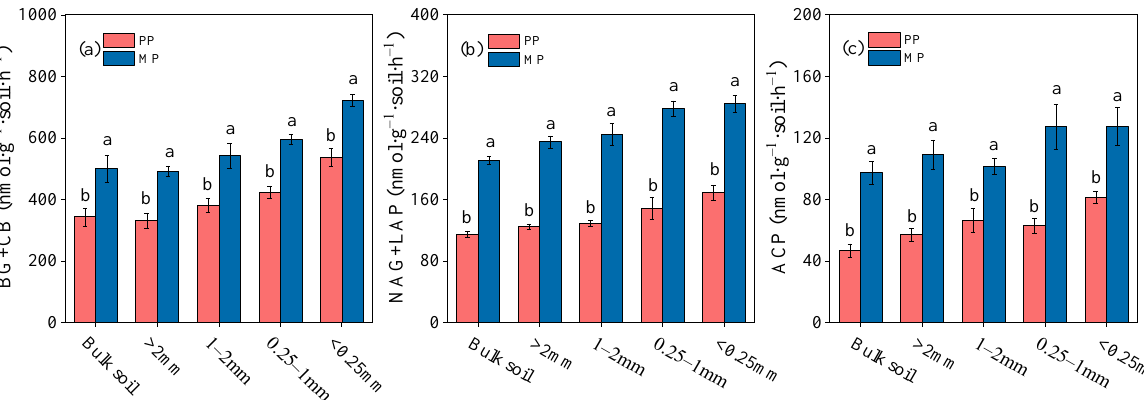
Figure 1. Soil extracellular enzymatic activity (EEA) within bulk soil and aggregates in PP and MP ( a – c ). Different lowercase letters denote marked variations between the PP and the MP ( p < 0.05). Error bars denote standard errors (n = 5).